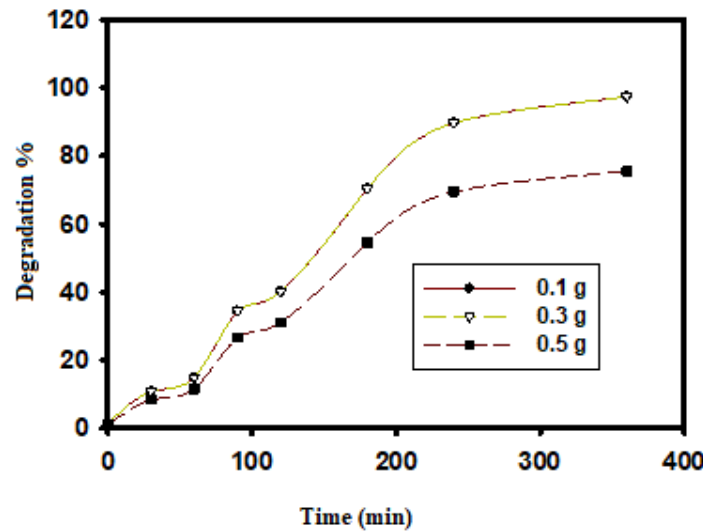
Figure 5. The effect of Ca-ALG/MgO/Ag nanocomposite beads catalyst on the degradation efficiency of Direct Red 83 dye with an initial concentration of 100 mg/L and 3 mL of 1 M NaBH 4